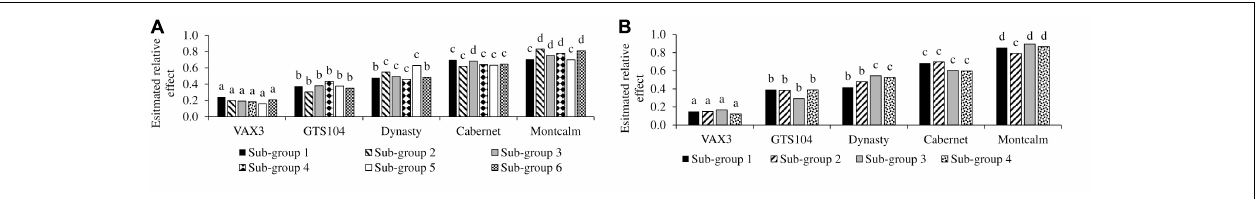
FIGURE 1 | Evaluation of the five control lines against root rot caused by Rhizoctonia solani AG 2-2 with sub-group evaluations of Phaseolus vulgaris (A) Andean Diversity Panel and (B) Mesoamerican Diversity Panel. Bars with same letters are not significantly different based on Fischer’s protected least significant difference ( α < 0.05).